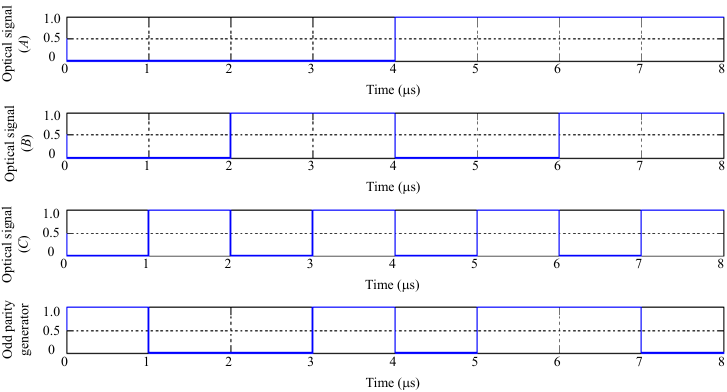
Fig. 8 Timing diagram of odd parity